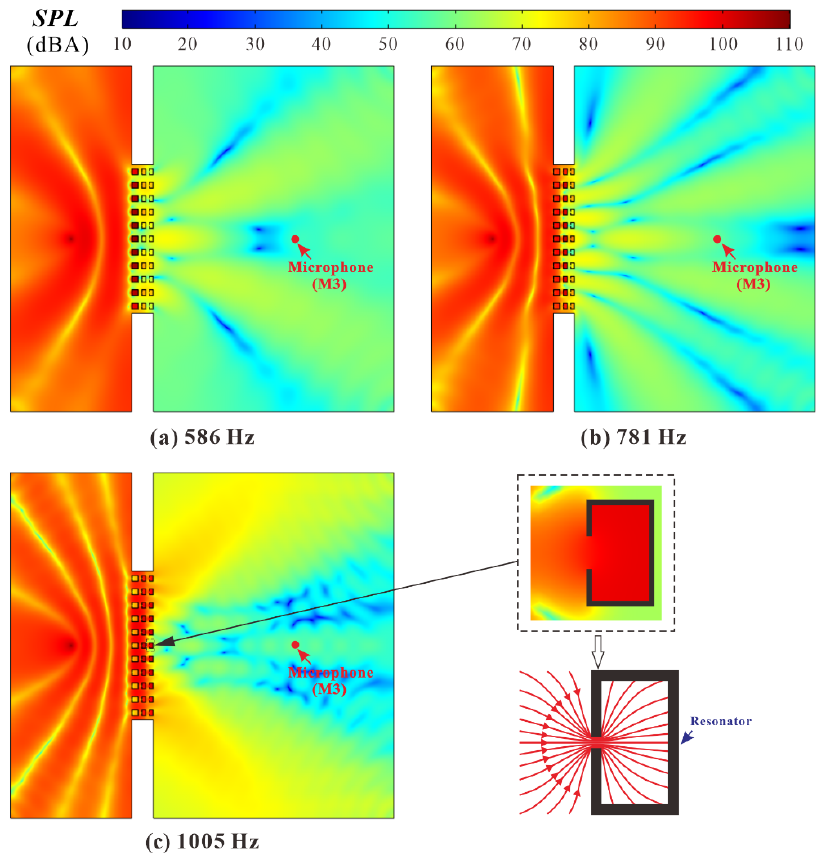
Figure 12. The contour of SPL activated by LRSCs at different frequencies, microphone at M3. ( a ) 586 Hz; ( b ) 781 Hz; ( c ) 1005